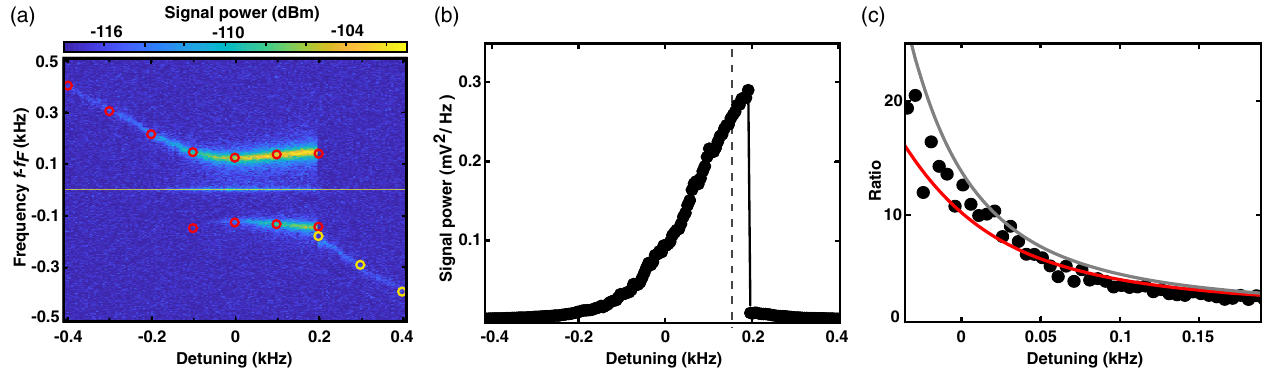
FIG. 4. (a) Color-coded power spectra showing the positions and intensities of the satellite peaks as a function of the detuning of the drive frequency f F − f 0 for the drive power − 20 dBm. The central line at f − f F ¼ 0 is plotted with a reduced brightness to improve the visibility of the satellites. Open circles denote the calculated positions for the high- (red) and low- (yellow) amplitude states [see Fig. 1(b)]. (b) The power of the signal at the drive frequency f F as a function of the detuning. The discontinuity observed at a detuning of 190 Hz indicates the switching of the resonator from the high- to the low-amplitude state for a slow ramp-up of the detuning. It coincides with the discontinuity of the satellite peaks in (a). The dashed gray line indicates the theoretically calculated critical switching point. (c) Ratio of the areas of the satellite peaks for the high-amplitude state as a function of the detuning. Red and gray lines show the theoretical predictions with and without the small overlapping of the satellite peaks,